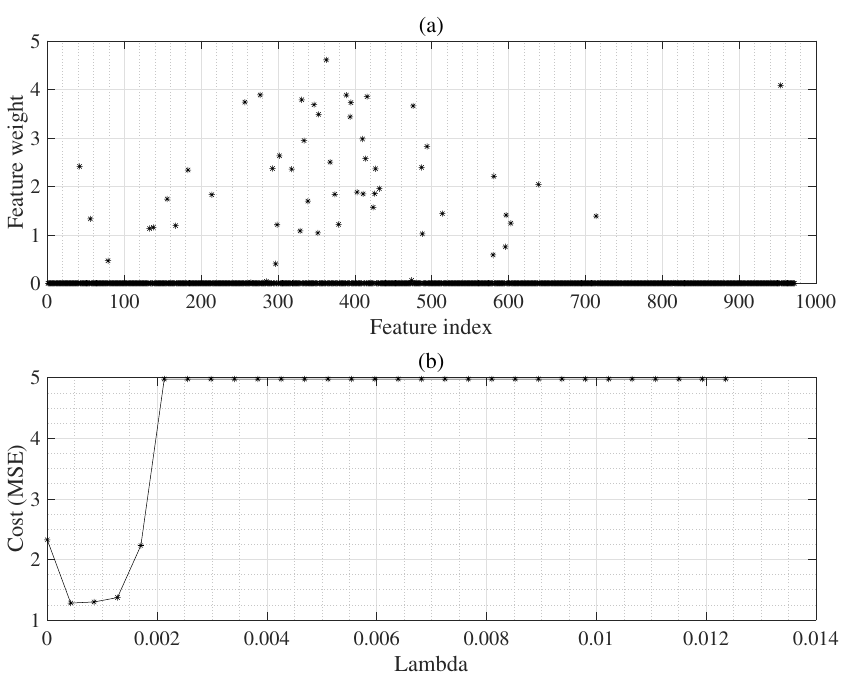
Figure 4. High weight features selection is performed using the RNCA model; where ( a ) is the weighted features and ( b ) is the regularization parameters λ